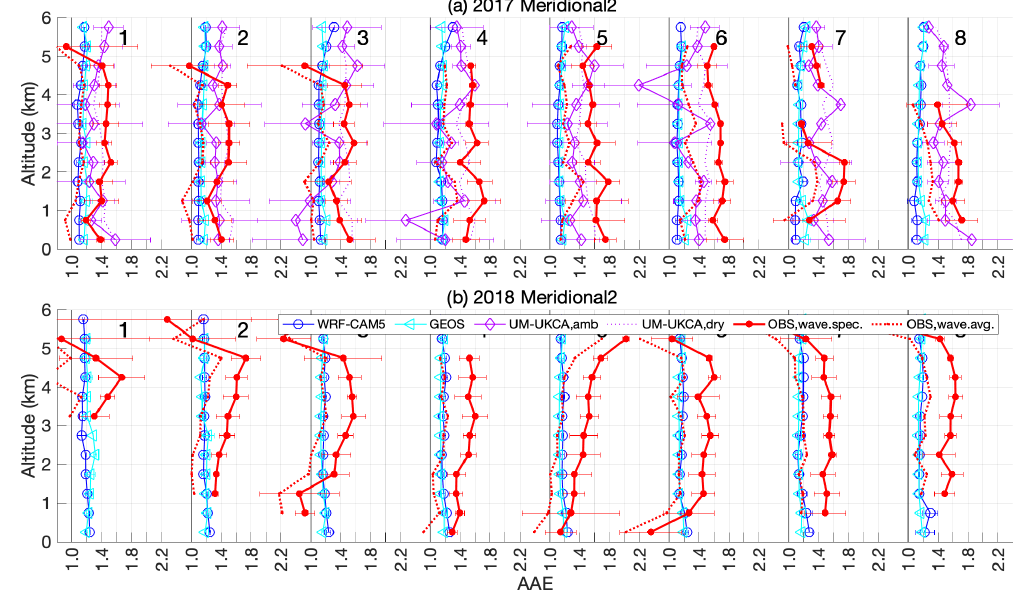
Figure 22. As in Fig. 17 but for the absorption Ångström exponent (AAE).